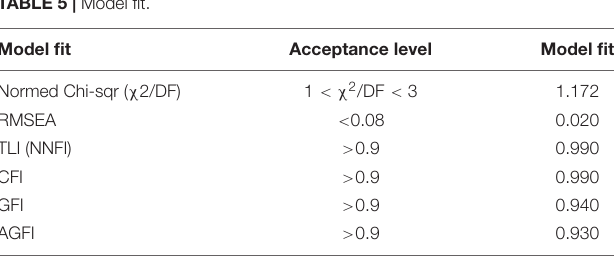
TABLE 5 | Model fit.